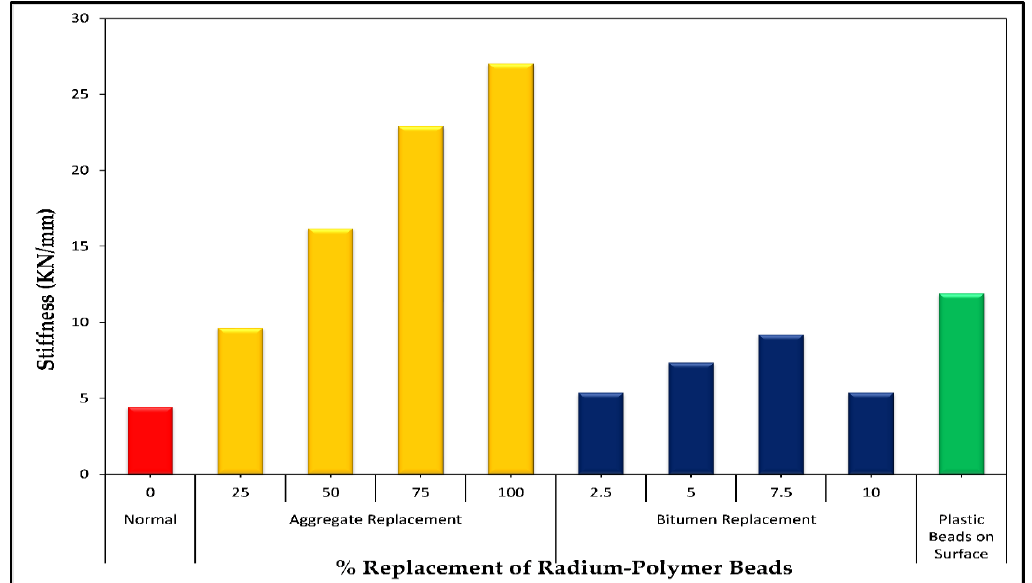
Figure 13. Stiffness versus radium polymer materials (%).